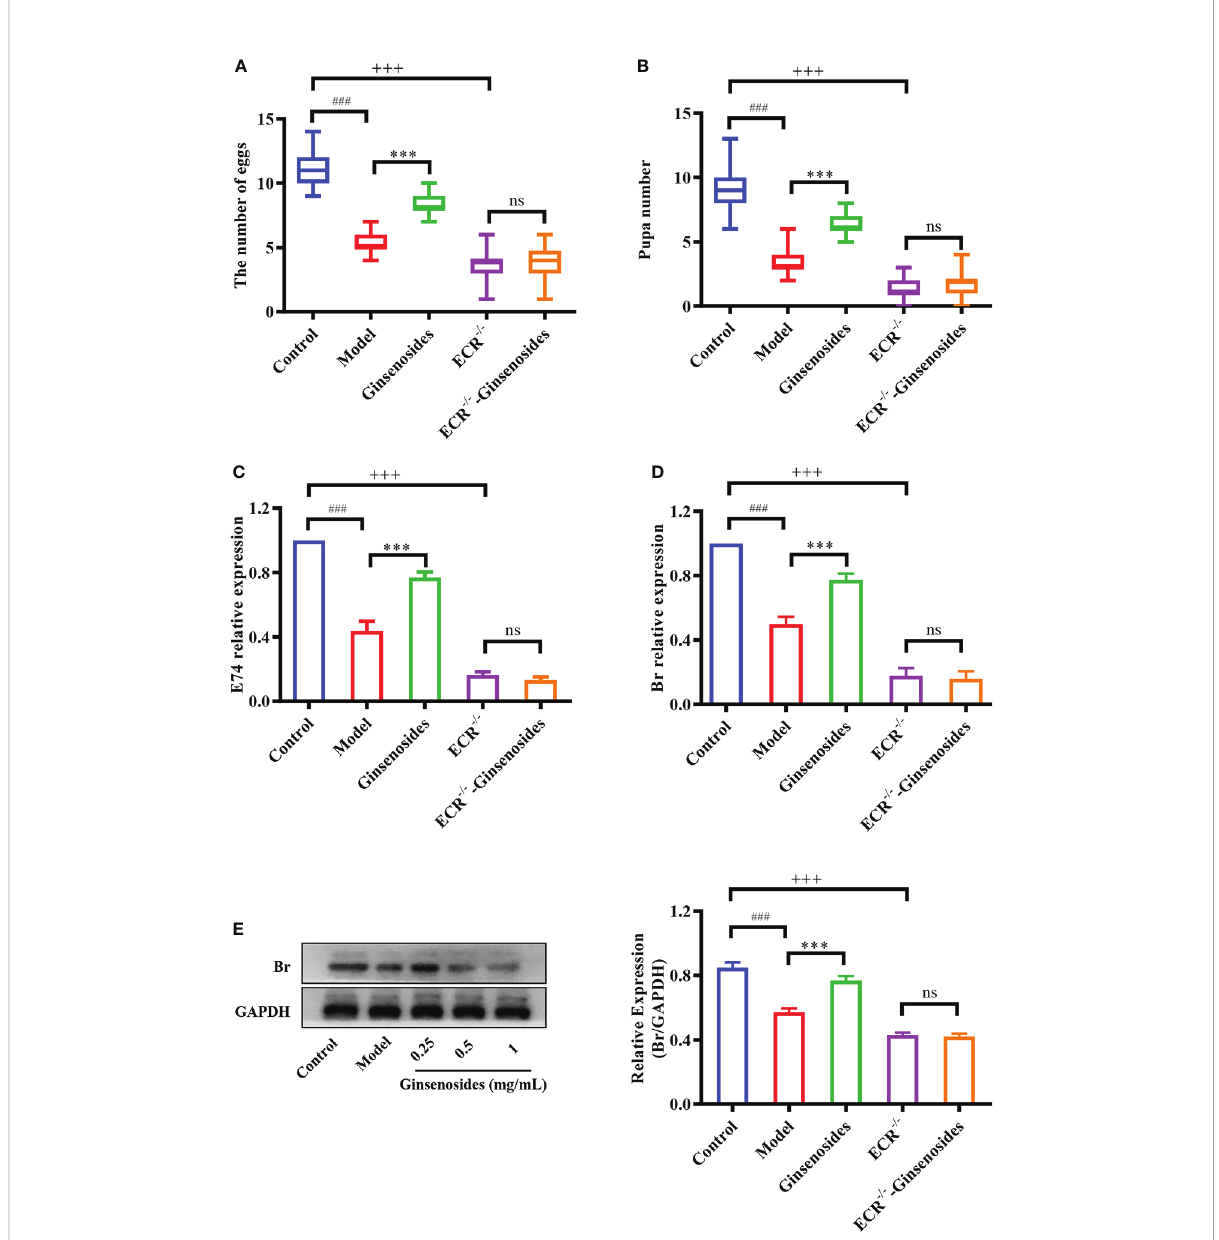
FIGURE 4 Effect of ginsenosides on the reproductive capacity of ECR mutant Drosophila . (A) The number of eggs; (B) The number of pupae; (C) Relative expression of gene encoding E74; (D) Relative expression of Br; (E) Relative expression levels of Br; GAPDH antibody was used as loading control. ### p <0.001 model compared with control (7-day-old female Drosophila ); *** p <0.001 compared with model (35-day-old female Drosophila ); +++ p <0.001 ECR -/- compared with control (35-day-old female Drosophila ); ns, no signi fi cance compared with ECR -/-